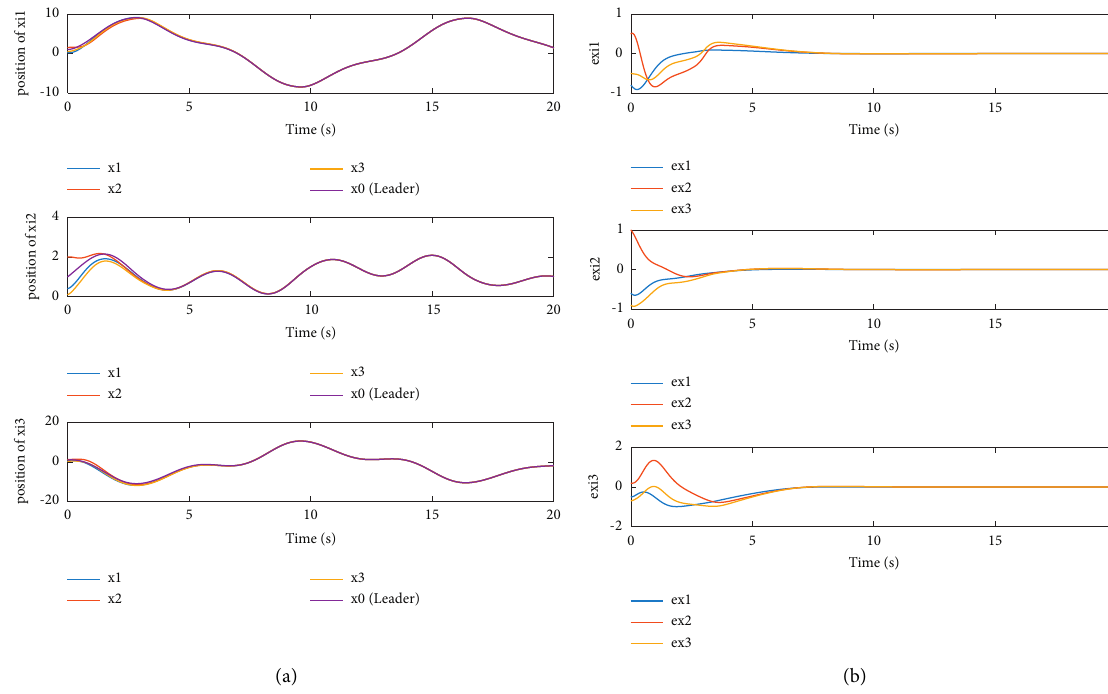
Figure 6: Position state and position error. (a) Position state. (b) Position error.